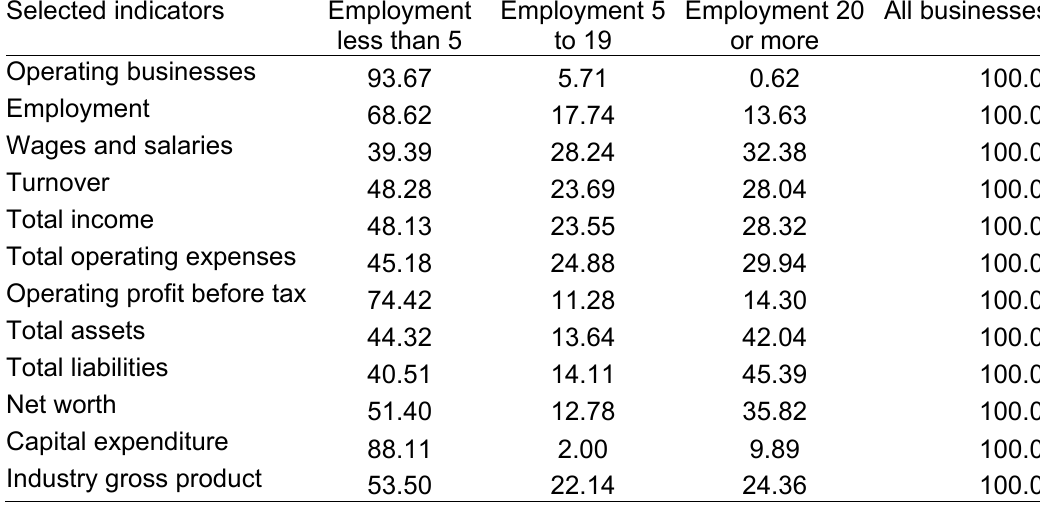
Table 4. Percentage by Firm